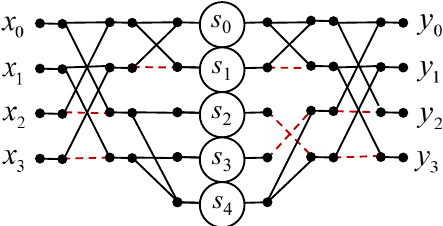
Figure 3. Algorithmic structure of the processing core for the computation of the 4-point circular